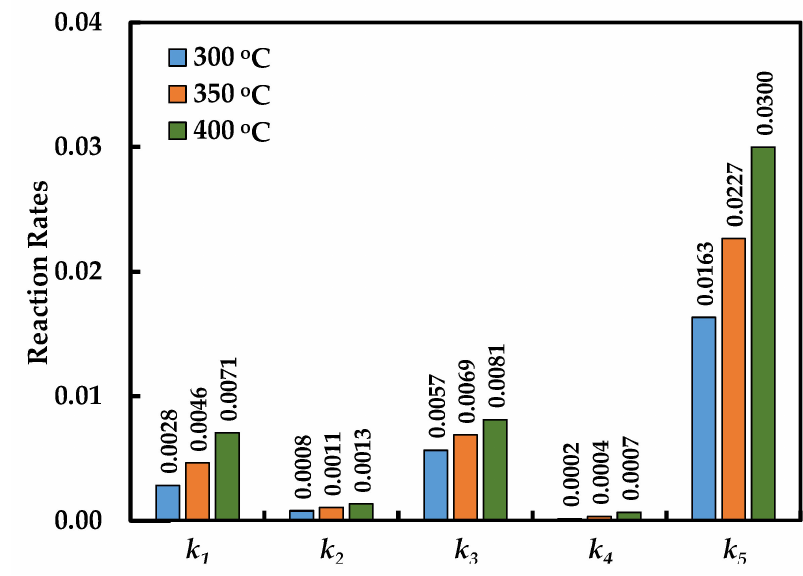
Figure 7. Comparison of rate constants of different